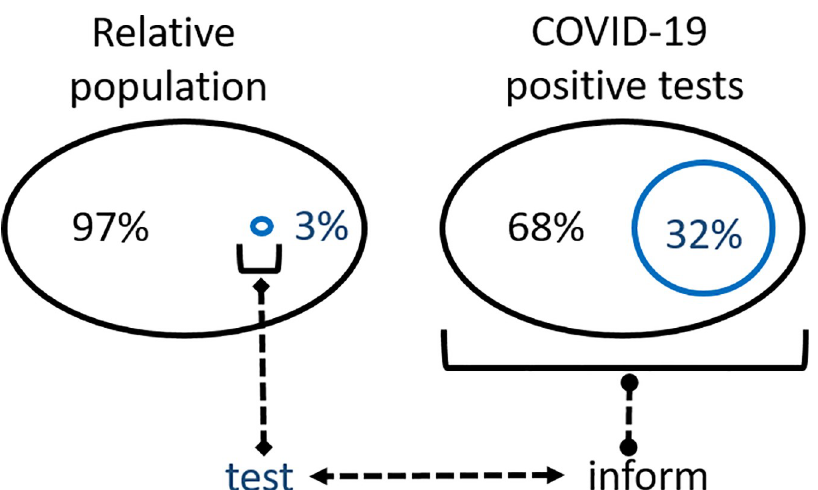
Fig 8. Schematic of relative populations and COVID-19 infections for the set (national population, black) and subset (HCWs, blue) in Ireland.